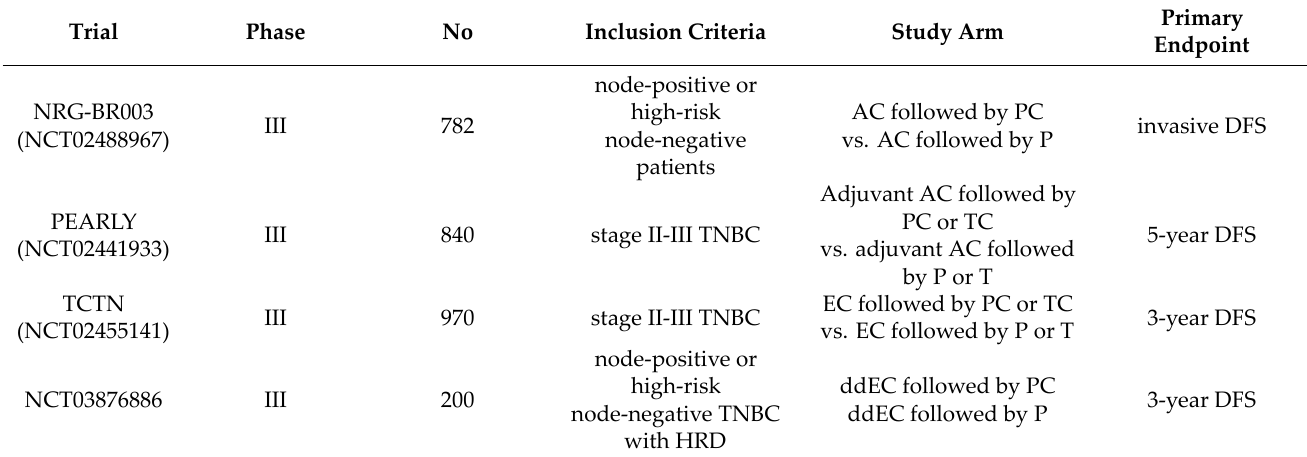
Table 1. Summary of ongoing trials investigating platinum in adjuvant